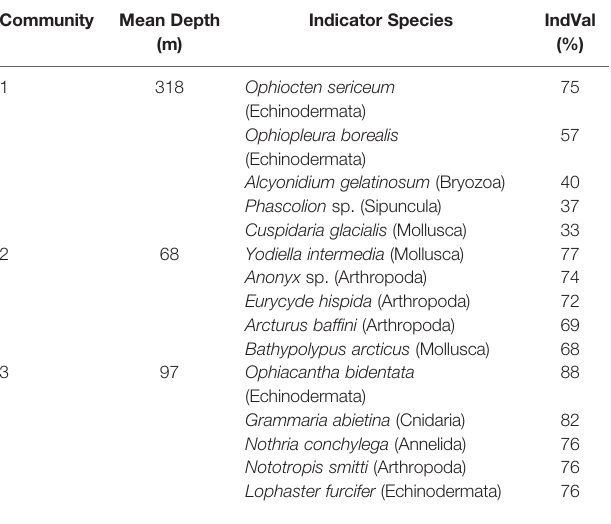
TABLE 3 | Indicator species (5 fi rst if available) of each benthic epifauna community in the Kitikmeot sea region and Parry Channel based on the IndVal Index.